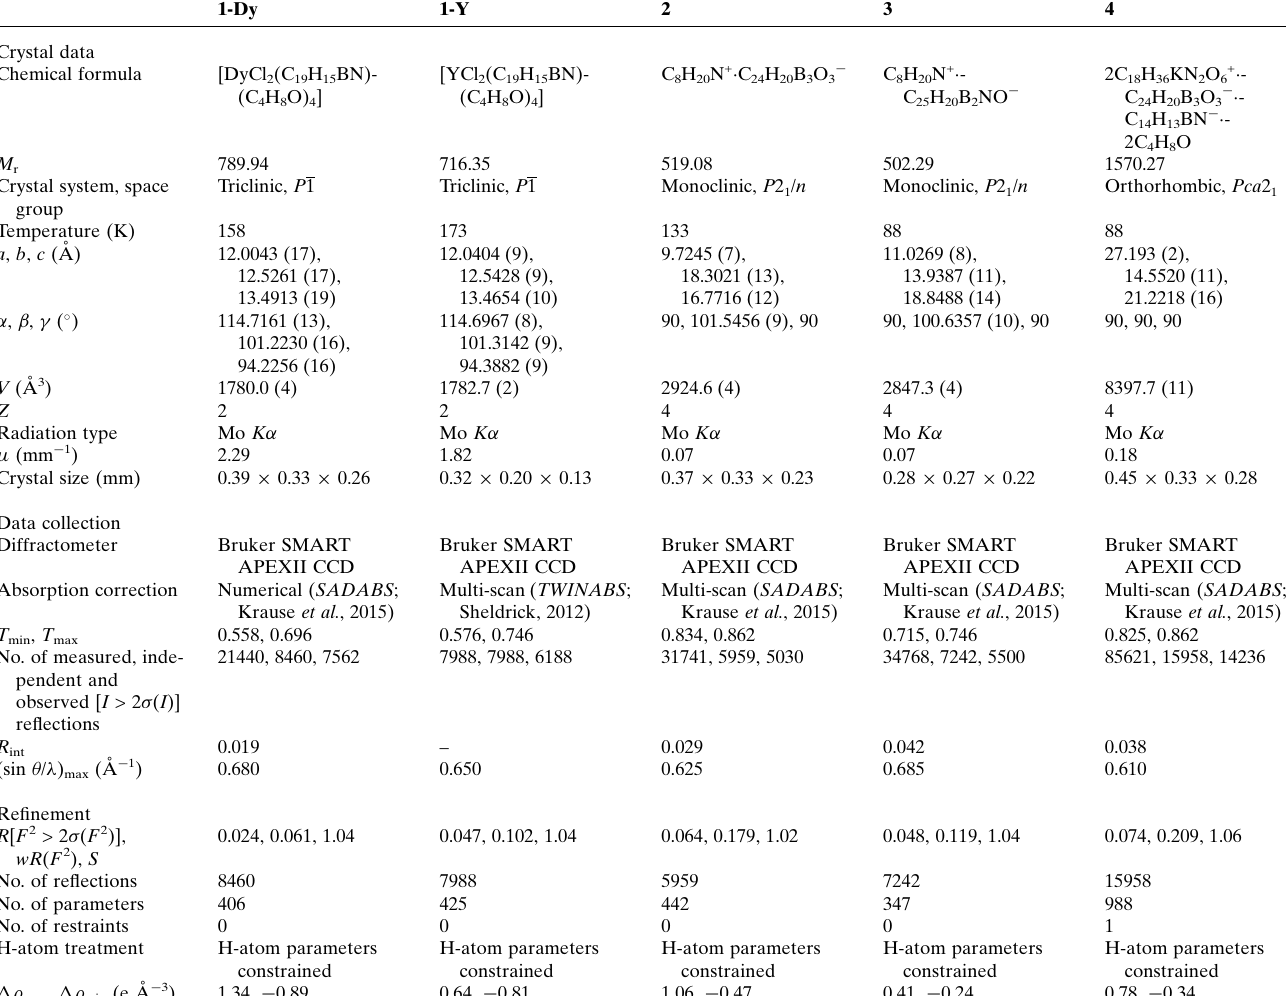
Table 2 Experimental